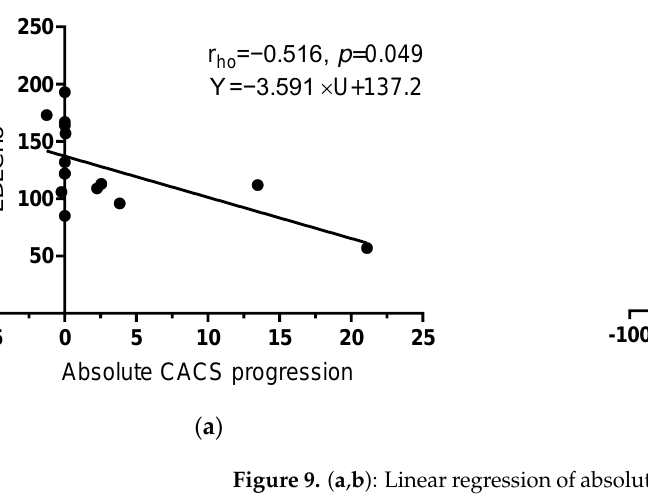
Figure 8. ( a – c ): Absolute calcification score progression during follow-up (pooled two-way ANOVA with *: p <0.05).